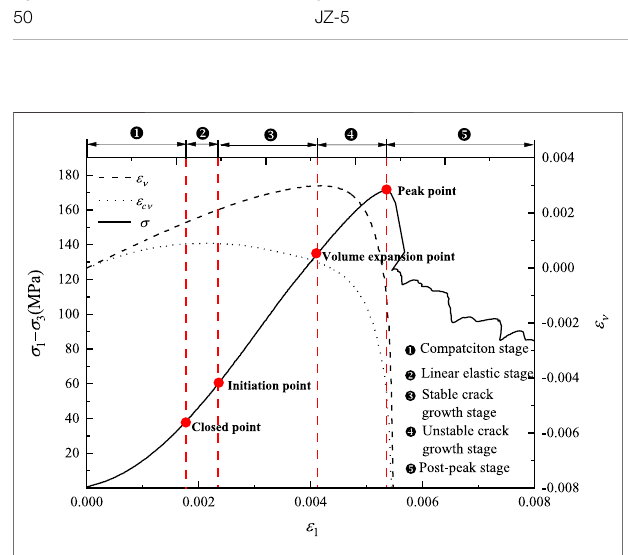
FIGURE 3 | Schematic diagram of the determination of each stage and characteristic stress of the stress – strain curve under σ 3 = 0 MPa.